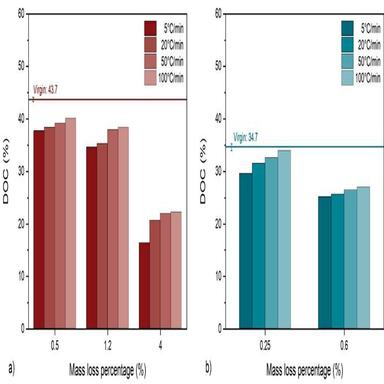
DOC of a) PEEK and b) CF-PEEK as degradation progresses for the heating rates of 5, 20, 50 and 100 ◦C/min.